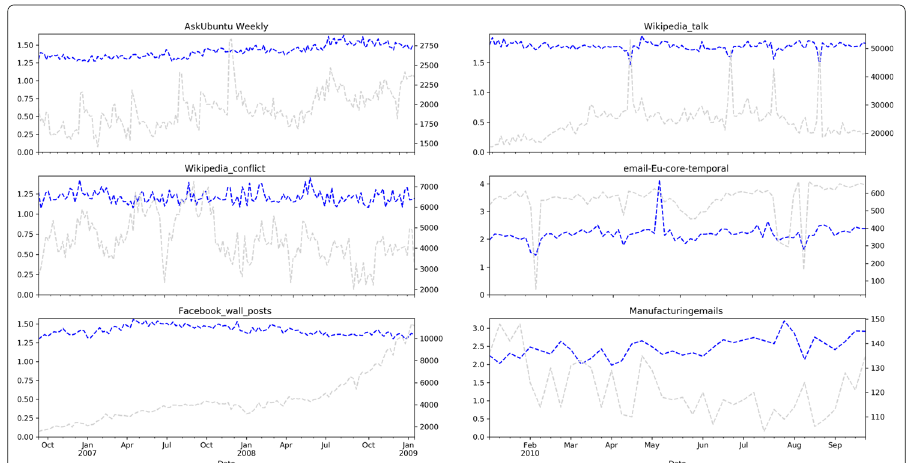
Fig. 2 Temporal average intensity for the six different datasets, denoted by the strong blue line. The values are denoted by the y-axis to the left. The light grey dashed line denotes the number of participating nodes during each period, i.e., the temporal size of the network. The size scale (i.e., number of nodes) is given by the right y-axis